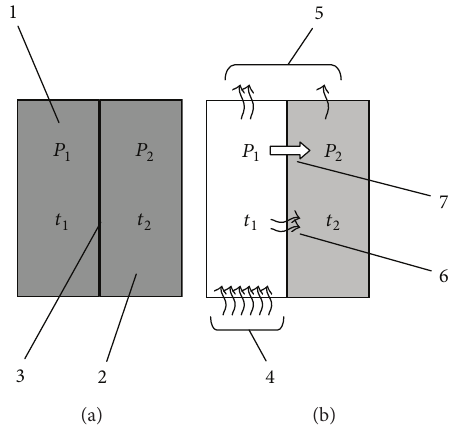
Figure 1: Change of the partial pressure of the gas in solutions separated by a gas-permeable membrane during the forced heating of one of them: (a) initial equilibrium state ( 𝑡 1 = 𝑡 2 = Const, 𝑃 1 = = Const), (b) heating ( 𝑡 > 𝑡 𝑃 > 𝑃 𝑃 2 1 2 ; 1 2 ). The wavy arrows are heat transfer; white arrows are the diffusion of the dissolved gas. (1) is the first liquid, (2) is second liquid, (3) is gas-permeable membrane, (4) is the heating of the first fluid from an external source of heat, (5) is heat loss, (6) is heating of the second liquid through the membrane, and (7) is diffusion of dissolved gases. The temperature of the first liquid which (1) is heated from the outside (4) increases faster than temperature of the second (2), and therefore the partial pressure of gases dissolved in the first liquid is also increasing rapidly. The resulting difference in partial pressures causes diffusion of dissolved gases(7)fromthefirstliquidintothesecondthroughgas-permeable membrane separating them